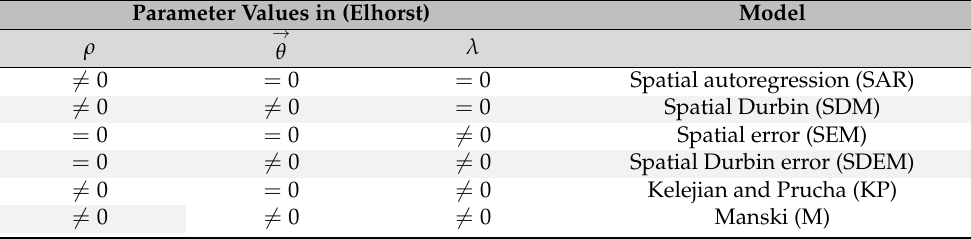
Table 2. Taxonomy of the Spatial Models’ Specifications. Parameter Values in